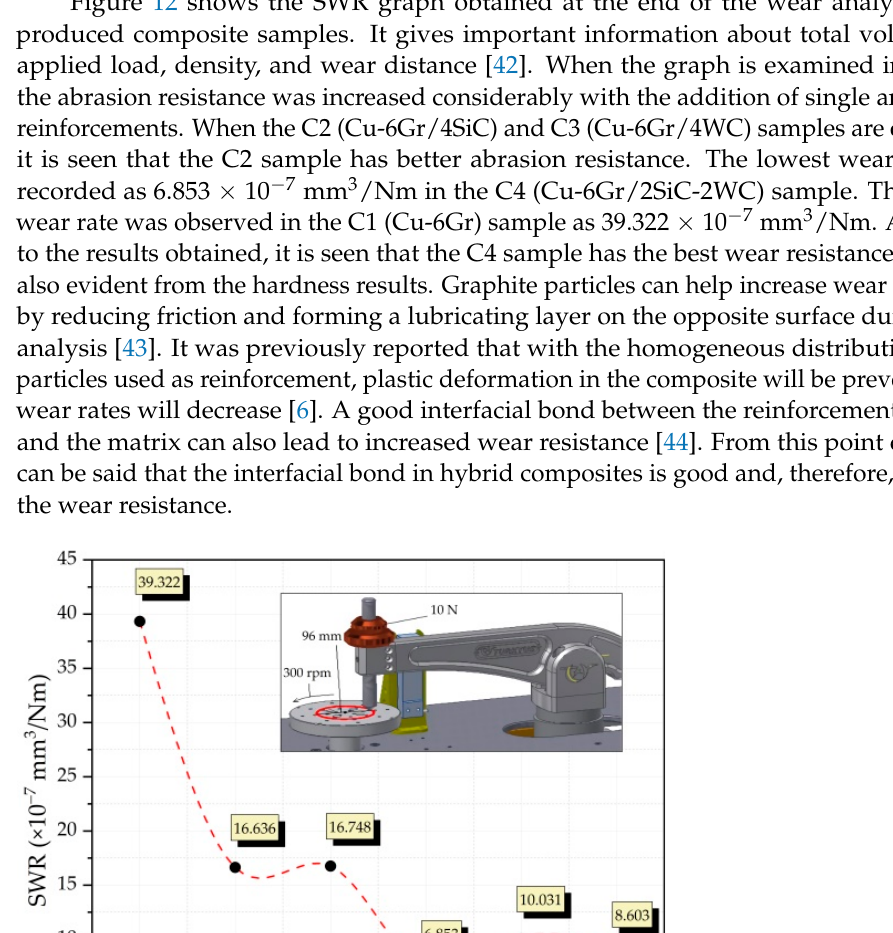
12 of 17 Figure 11. Fractured surface SEM micrographs after the three-point bending test.